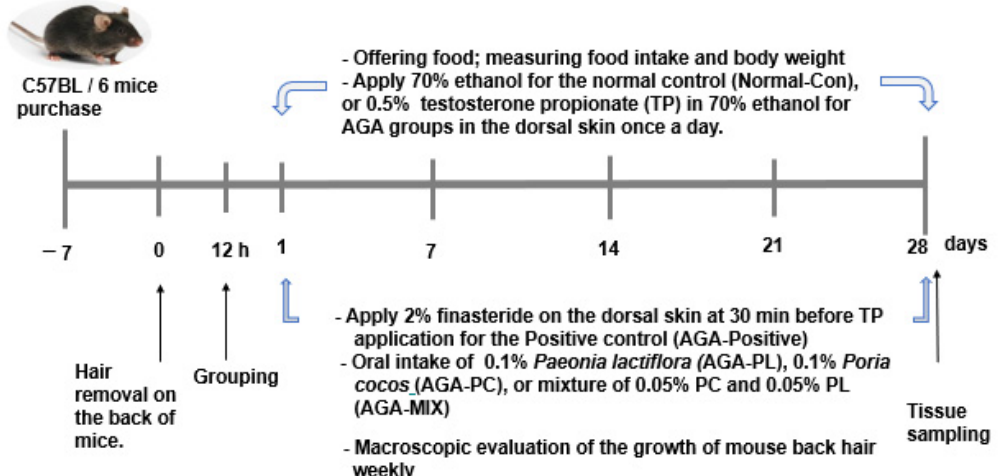
Figure 2. Experimental design of the animal study. AGA was induced with the application of 0.5% testosterone propionate solution on the back of mice, and AGA-induced mice orally consumed 0.1% PL, 0.1% PC, or 0.1% mixture of PL and PC (1:1, w / w ) in a 43% fat diet (HFD), called AGA-PL, AGA-PC, or AGA-MIX groups, respectively. AGA-induced mice were daily applied with 2% finasteride on the back, as AGA-Positive (positive control). AGA-Positive and AGA-Con (control) mice had 0.1% cellulose (no effective activity in AGA treatment) in an HFD. Normal-Con did not induce AGA and consumed 0.1% cellulose in an HFD. All mice had an 8-week